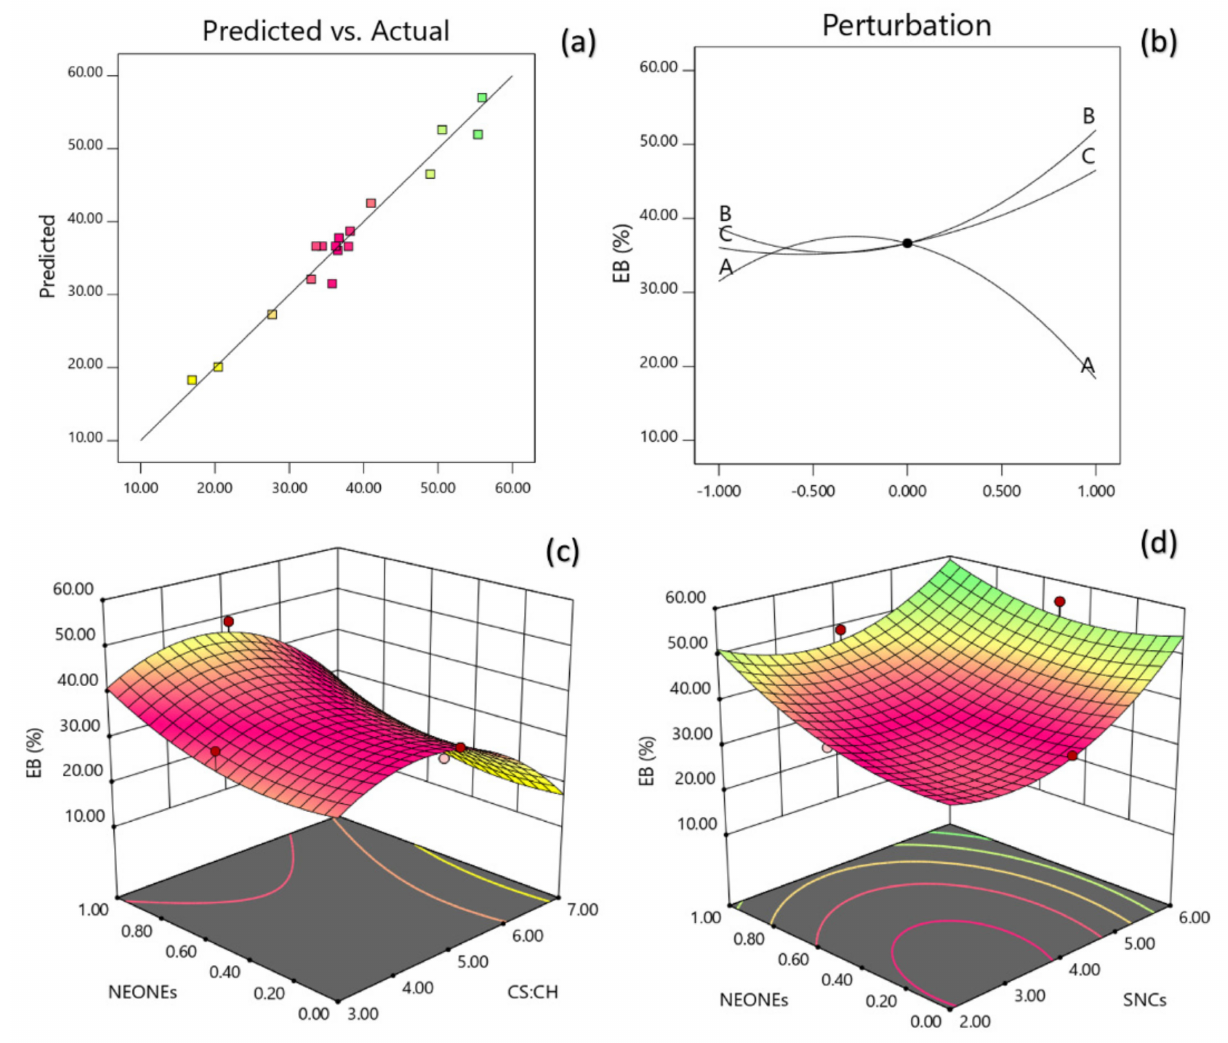
Figure 9. Counter and perturbation graphs ( a , b ), the interaction between CS:CH and SNCs concentration and also interaction between SNCs and NEONEs concentration on elongation at break (EB) of the produced film ( c , d